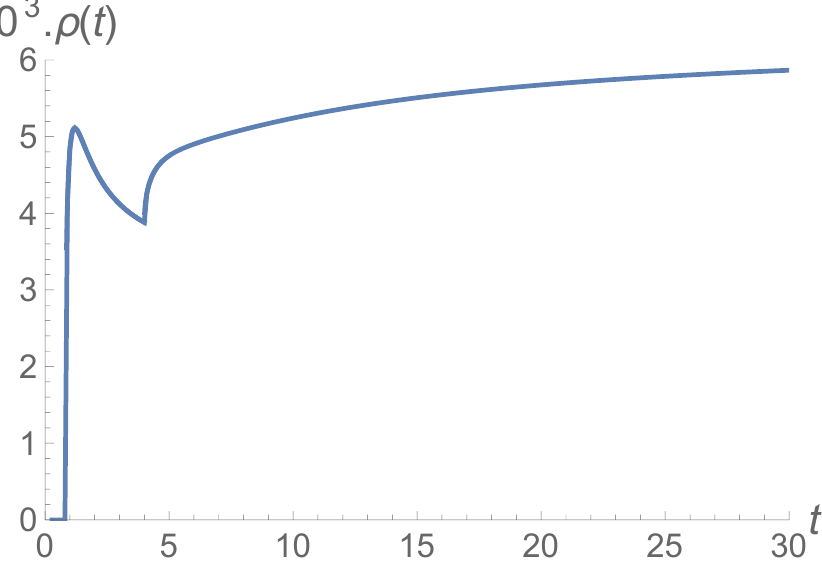
Figure 11 . Spectral function for the reduced propagator of the scalar composite operator, h O ( p ) O ( (cid:0) p ) i , with all quantities given in units of appropriate powers of the energy scale (cid:22) ,